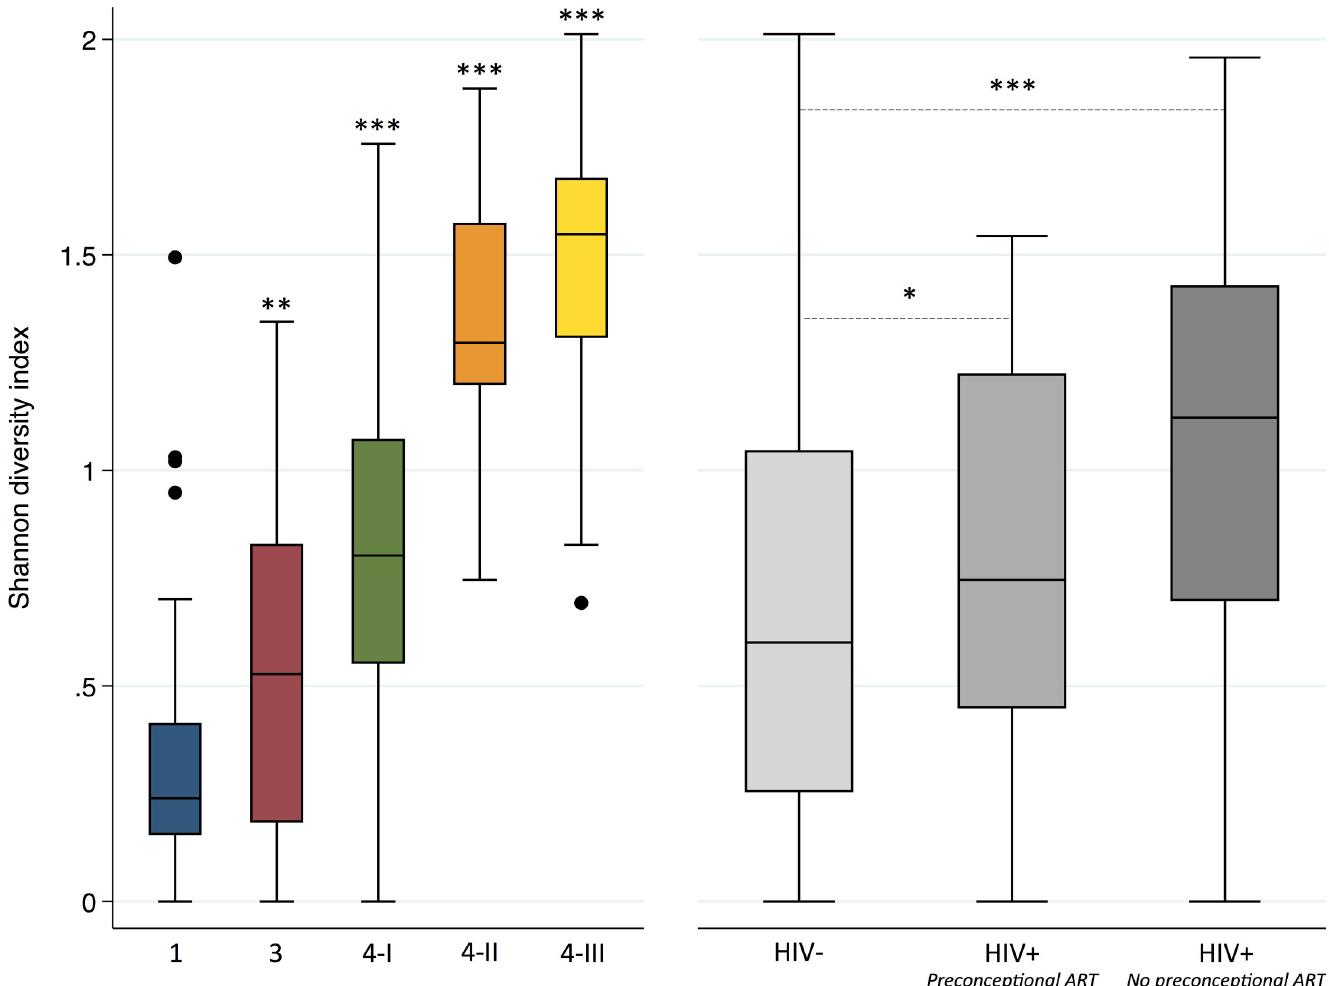
Fig 4. Shannon diversity indices by community state type (panel A) and by HIV serostatus and timing of initiation of antiretroviral therapy (panel B) in pregnant ZAPPS cohort. Species diversity of the vaginal microbiome increases across CSTs; Lactobacillus -dominant CSTs 1 and 3 have the lowest diversity and anaerobe-dominant CSTs have highest diversity. Diversity is higher among HIV-infected participants with and without preconceptional ART exposure compared to uninfected participants. p values calculated by linear regression of Shannon diversity index between individual CSTs compared to CST1 (panel A) and between exposure groups (panel B) All analyses weighted for sampling. � p = .04, �� p = .001, ��� p < .001 CST, community state type; ART, antiretroviral